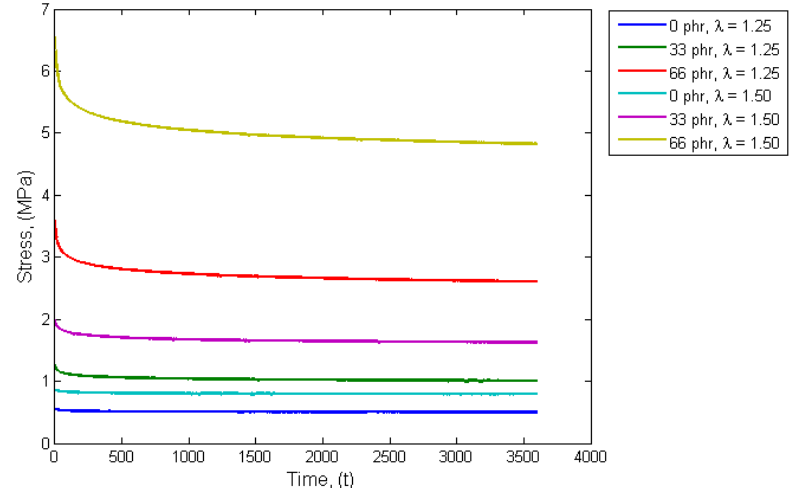
Figure 8. Stress relaxation for unfilled and filled dumbbells at different strain levels.